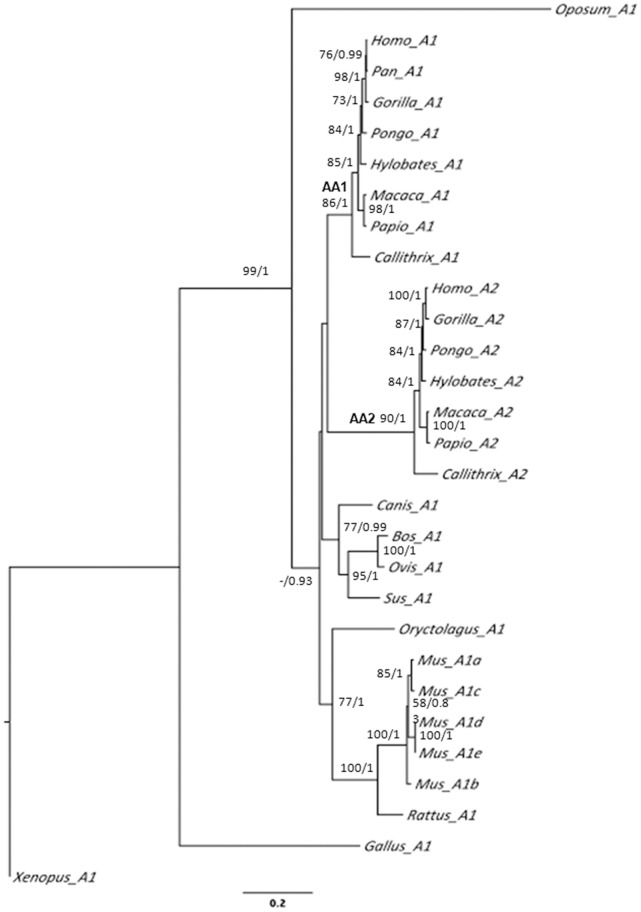
Maximum likelihood phylogenetic tree of SERPINA2 and SERPINA1.Values shown by nodes are the bootstrap values and posterior probabilities obtained from the Bayesian Inference analysis. AA1– Ancestral SERPINA1 branch for primates. AA2– Ancestral SERPINA2 branch.